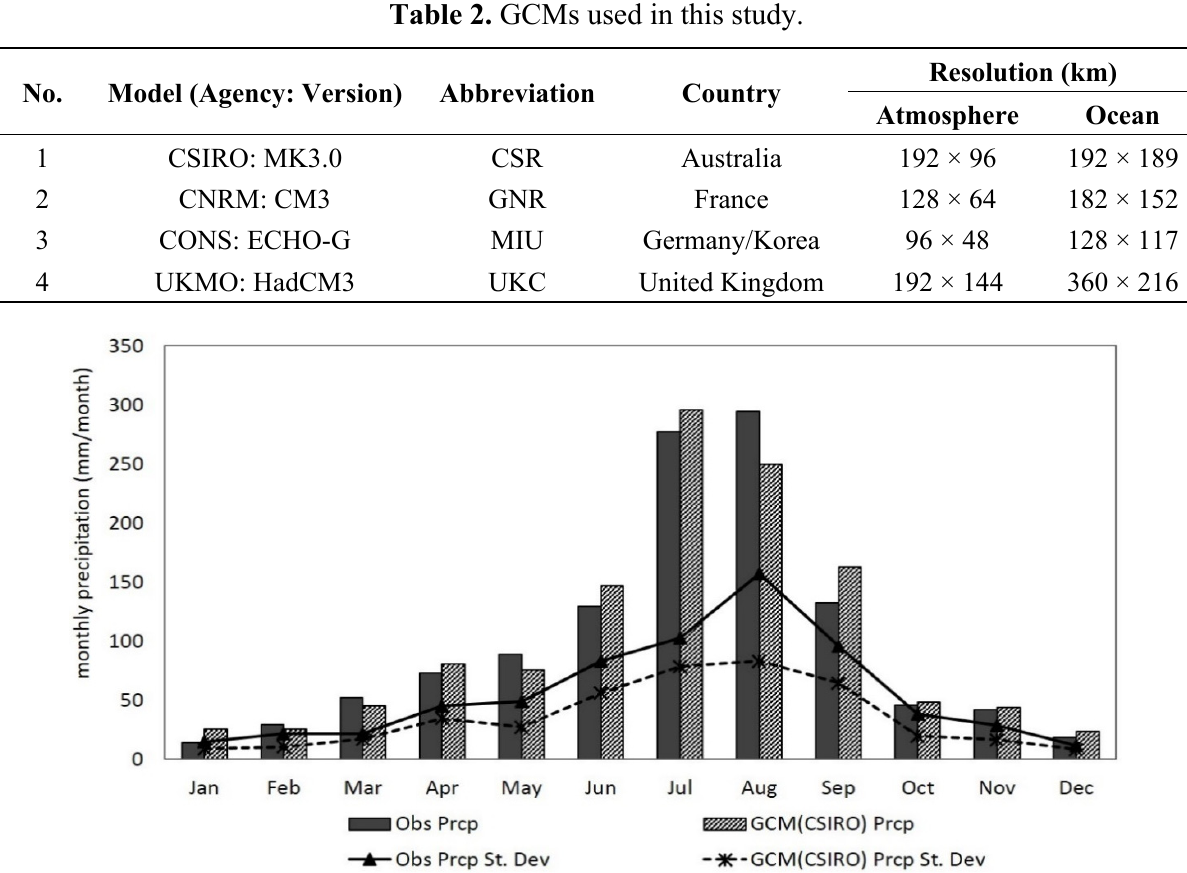
Figure 4. Mean monthly precipitation and standard deviation of observed and GCM-simulated series